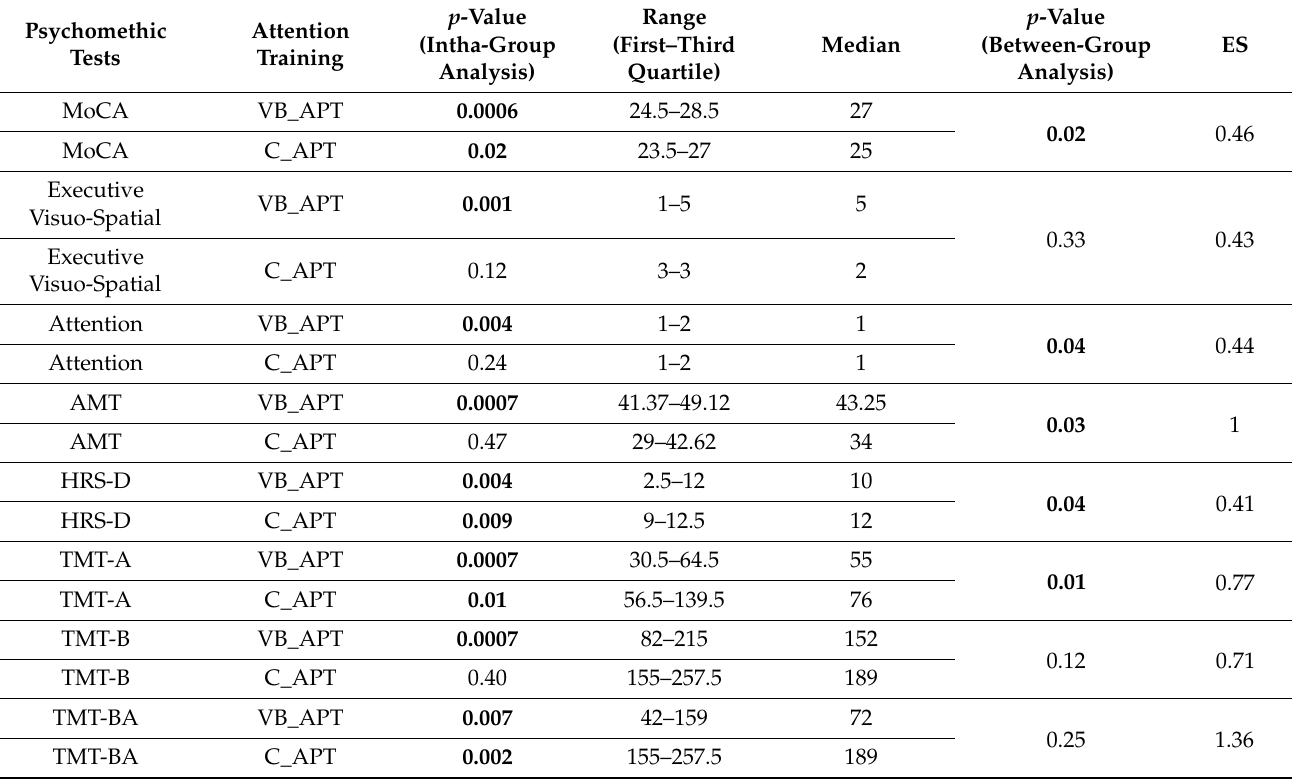
Table 4. Median and first–third quartile of the administered psychometric tests in TBI patients, between virtual-based approach with VVRS and the conventional one. Wilcoxon signed the rank test for the intra-group analysis and Mann–Whitney’s test of neuropsychological evaluation between two groups. Significant p -values are in